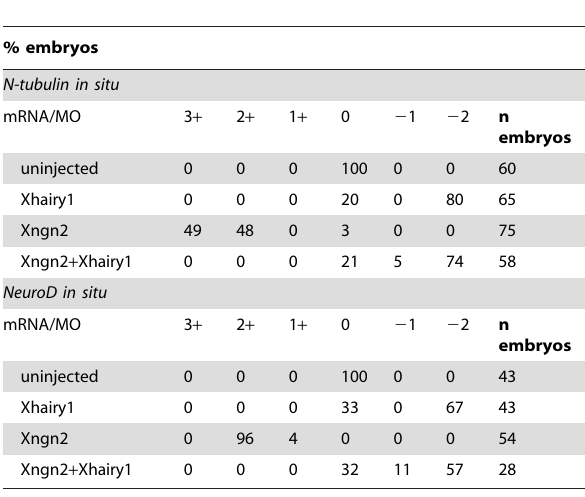
Table 4. Effect of Xhairy1 on Xngn2 activity.